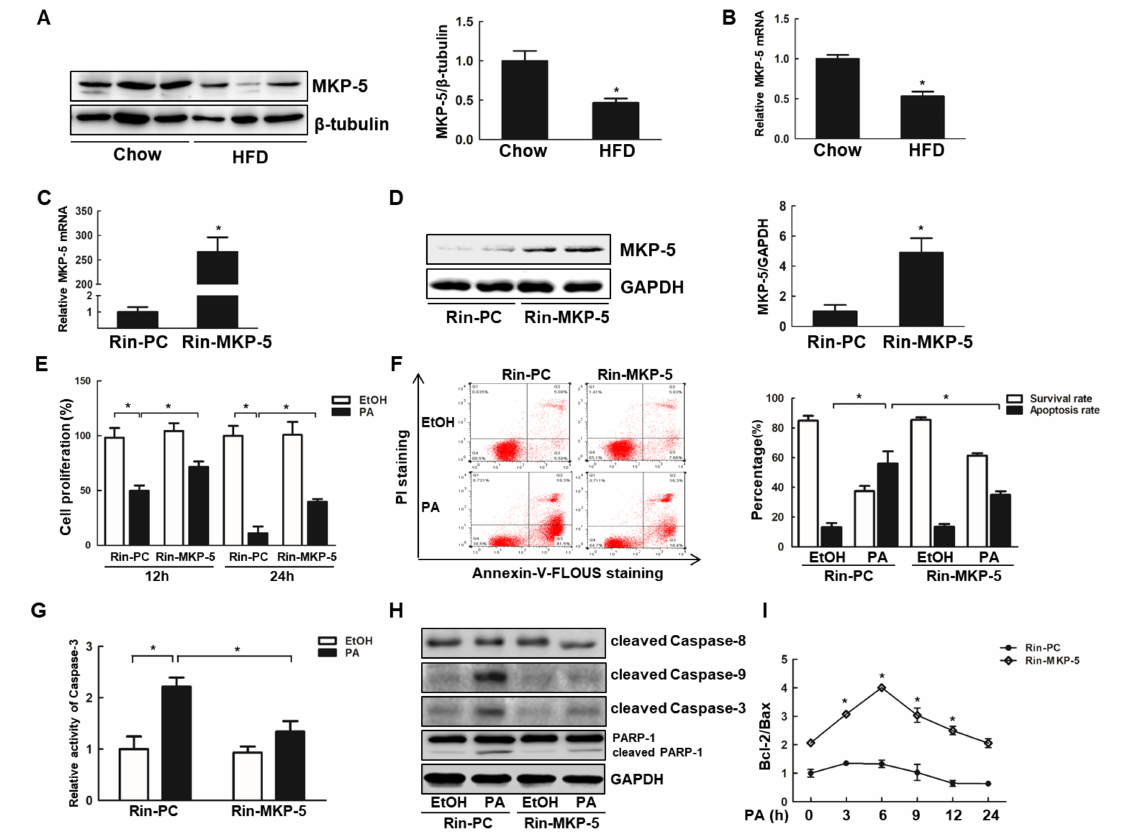
Figure 1. Overexpression of mitogen-activated protein kinase phosphatase-5 (MKP-5) relieves the apoptosis of Rin-m5f cells upon palmitic acid (PA) exposure. ( A ) Representative pancreatic MKP-5 expression in mice fed high-fat diet (HFD) or chow as measured by Western blotting (male mice; n = 7 per group, left). Levels of MKP-5 were quantified and normalized to β -tubulin in these same mice (right). ( B ) The expression of MKP-5 in islet cells from mice fed HFD or chow was measured by real-time PCR (male mice; n = 7 per group). ( C , D ) The Rin-PC and Rin-MKP-5 cell lines were constructed, and the level of MKP-5 was measured by real-time PCR ( C ) and Western blotting. (( D ), Left) Levels of MKP-5 were quantified and normalized to glyceraldehyde-3-phosphate dehydrogenase (GAPDH) (( D ), Right). ( E ) The cell proliferation of Rin-PC and Rin-MKP-5 cells treated with PA for 12 and 24 h was measured via 3-(4,5-dimethylthiazol-2-yl)-5-(3-carboxymethoxyphenyl)-2-(4-sulfophenyl)-2H-tetrazolium, inner salt (MTS) assay. ( F ) The apoptotic ratios of the cells following a 24 h palmitic acid (PA) treatment were quantified based upon Annexin V and propidium iodide (PI) staining results. ( G ) Caspase-3 activity was measured using Ac-DEVD-PNA in Rin-m5f cells exposed to PA for 24 h. ( H ) Levels of cleaved Caspase-9, cleaved Caspase-8, cleaved Caspase-3, and cleaved poly (ADP-ribose) polymerase-1 (PARP-1) in Rin-PC and Rin-MKP-5 cells treated with PA for 9 h were measured via Western blotting. ( I ) The relative levels of B-cell lymphoma-2 (Bcl-2) / Bcl-2 associated X protein (Bax) were measured by real-time PCR in Rin-m5f cells treated with PA for the indicated times. *, p < 0.05, Rin-PC vs. Rin-MKP-5; EtOH vs. PA; HFD vs.